Question: Which kind of chart has been used to present this data?
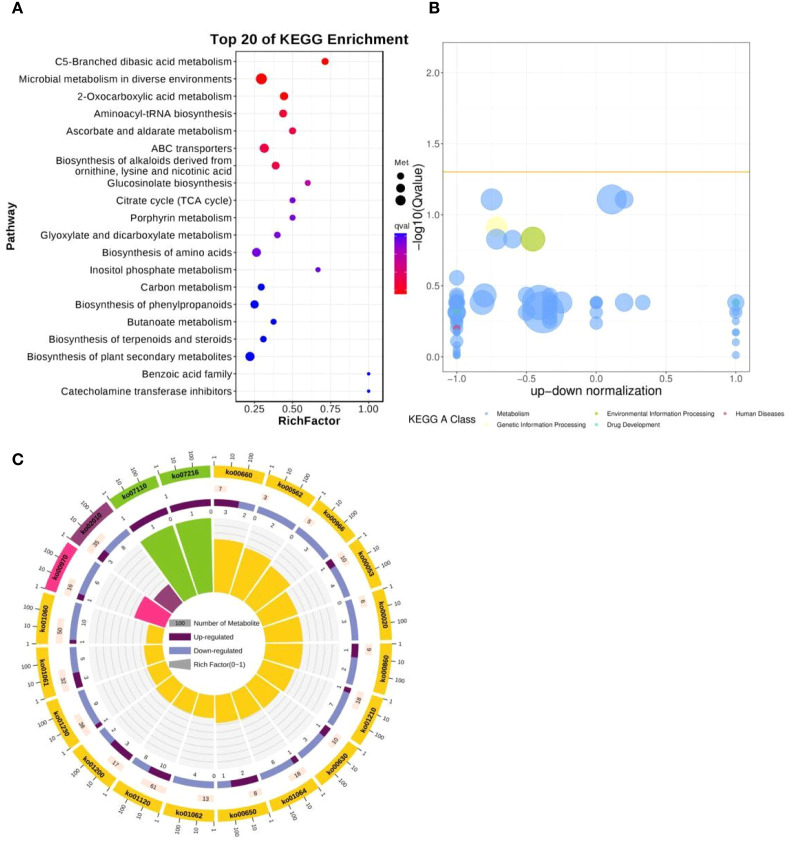
Answer: bar